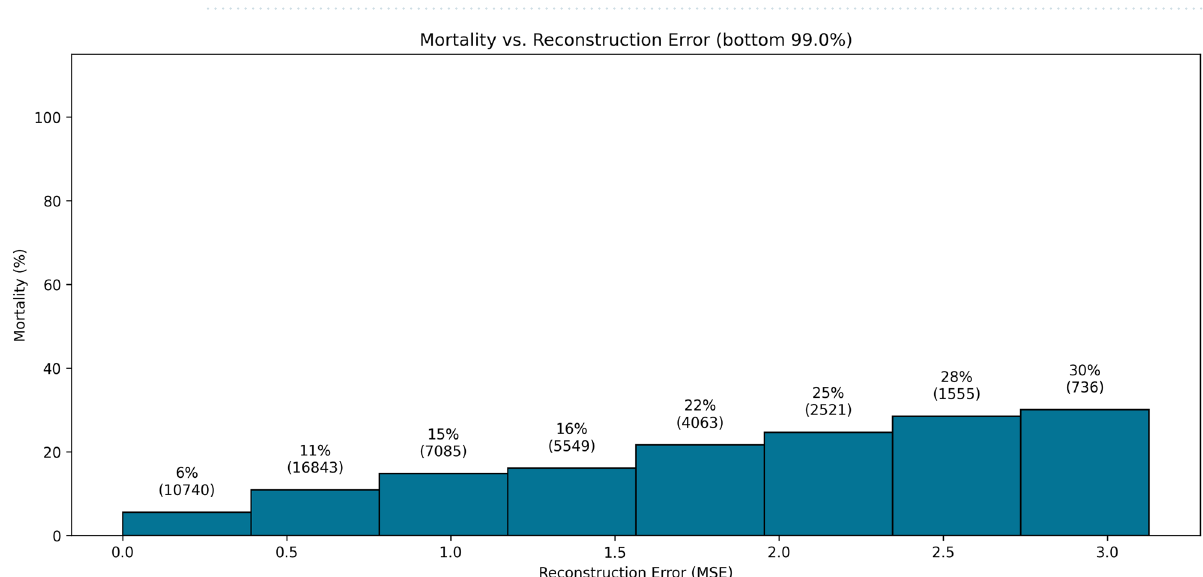
Figure 2. Relationship between reconstruction error and mortality. For every admission, we assess the mean squared reconstruction error over all time steps and the 28-day mortality. We show admissions within different ranges of reconstruction error as bars, with the fraction of admissions with mortality and the total count of admissions displayed above each bar. On average, admissions with higher reconstruction error have higher mortality: Between the admissions with low reconstruction error and those with high reconstruction error, there is a five-fold increase in mortality. For this plot, we only include the bottom 99% of admissions (concerning the reconstruction